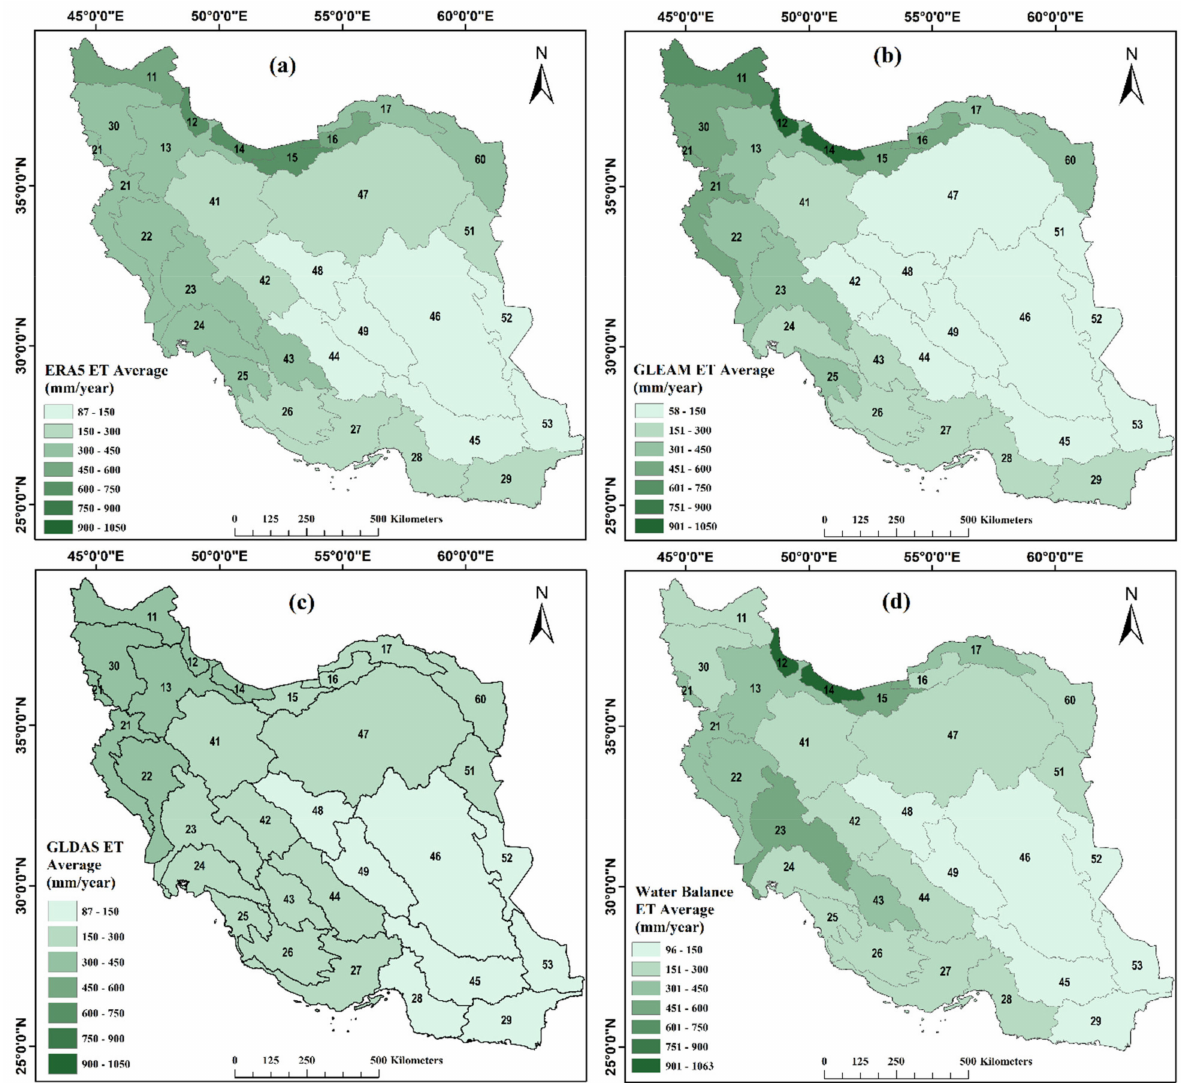
Figure 6. Long-term annual average evapotranspiration (ET, mm) in Iran’s basins during the period 1986–2016, according to ( a ) ERA5, ( b ) GLEAM, ( c ) GLDAS, and ( d ) Water Balance